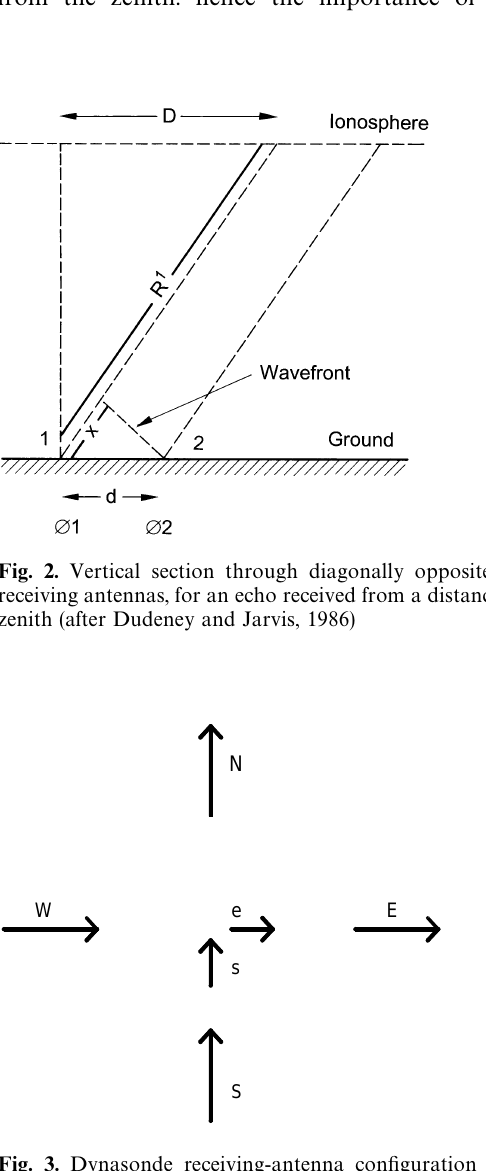
Fig. 3. Dynasonde receiving-antenna configuration used for the experiment SP-UK-DYNA. The six dipoles are arranged along the diagonals of a 100 m square, giving a N-S, W-E spacing of 141 m, and are spaced along the diagonals in the ratios 0:2:3 from the north and west (Pitteway and Wright, 1992)